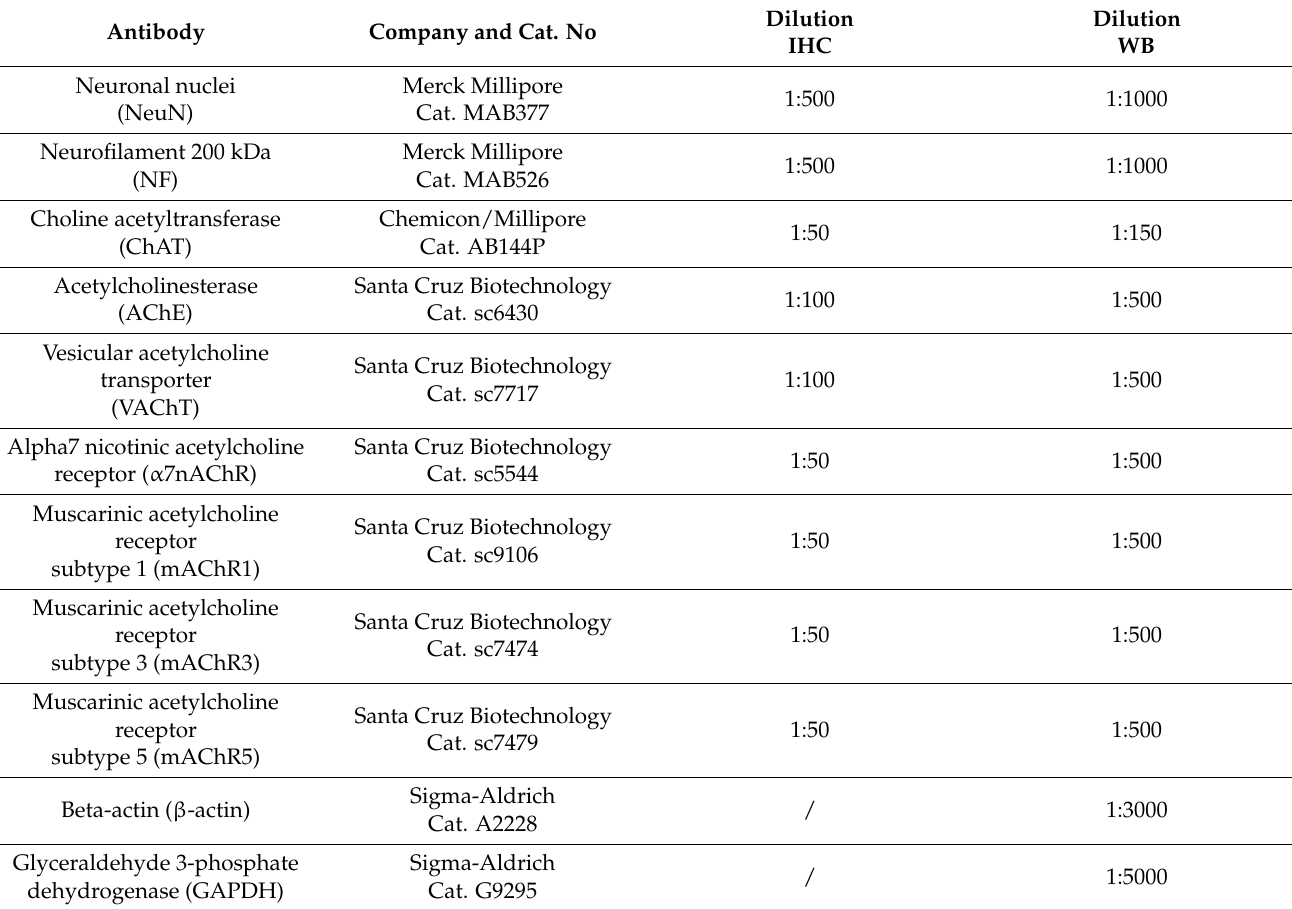
Table 1. Primary antibodies used in immunohistochemistry (IHC) and Western blot (WB).